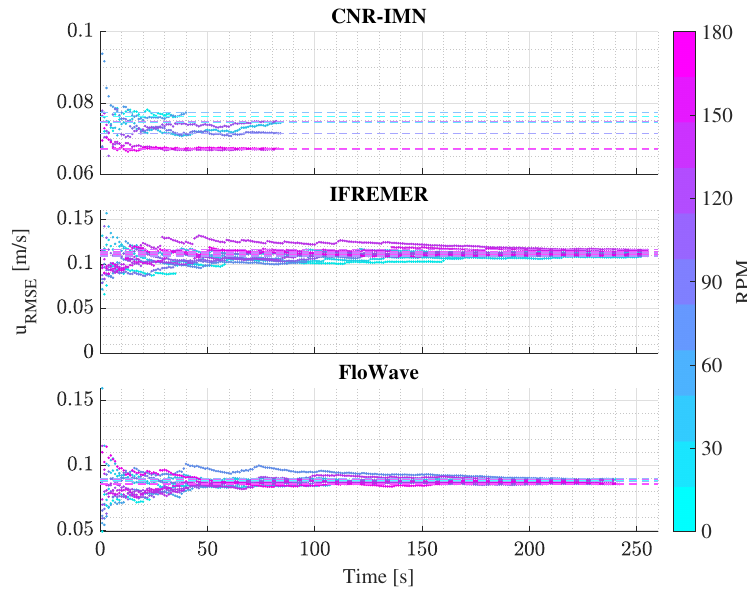
Figure 19. Stabilisation of the RMSE of u for case 1 at all